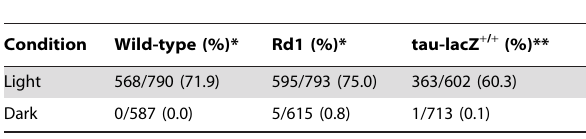
Table 1. Light-induced Fos expression in